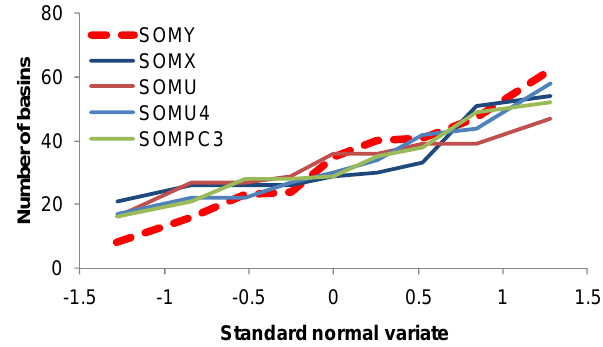
Fig. 7. Sample cumulative distribution function of the number of basins in each